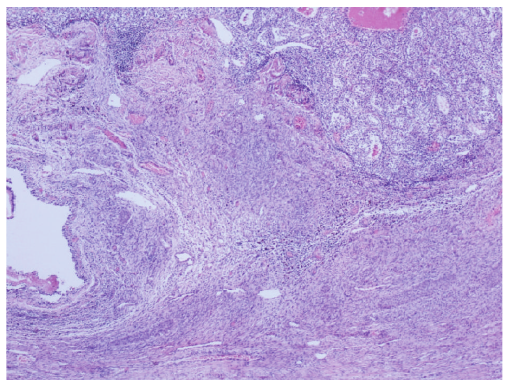
Figure 6: The three components: RCC, Brenner tumour, and Mucinous